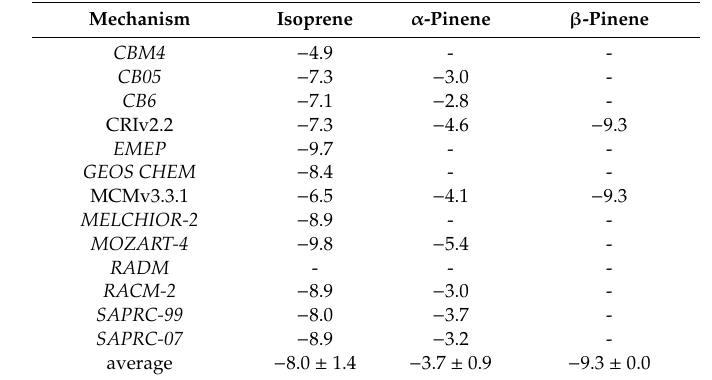
Table 5. Initial a hydroxyl radical incremental reactivities for the biogenic alkenes and alkadienes in units of 10 6 molecule cm − 3 per ppb hour − 1